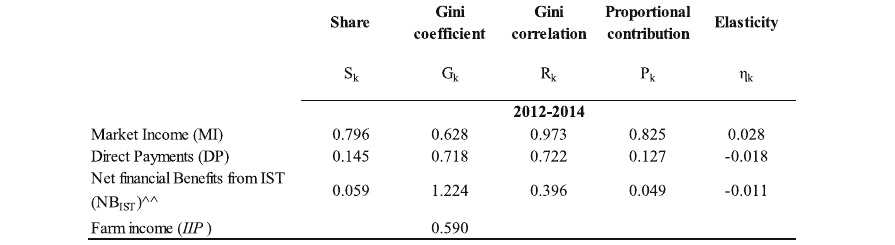
Table 8 Gini decomposition by income sources whole period 2012 – 2014